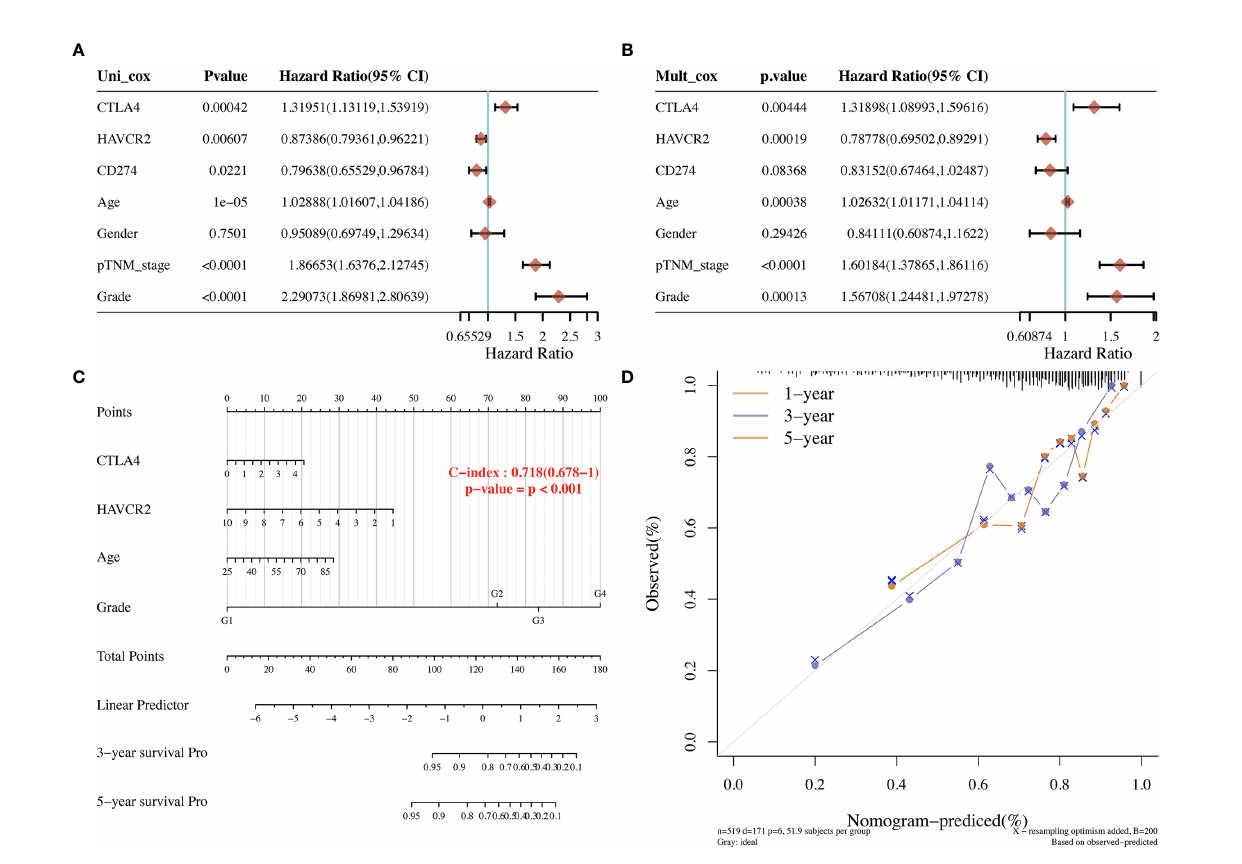
FIGURE 4 | Univariate and multivariate cox regression of immune checkpoints in KIRC. (A, B) Univariate and multivariate cox regression of KIRC patients ’ parameters and prognostic biomarkers of immune checkpoints. (C, D) The predictive nomogram to predict the 3-y and 5-y overall survival of KIRC cancer